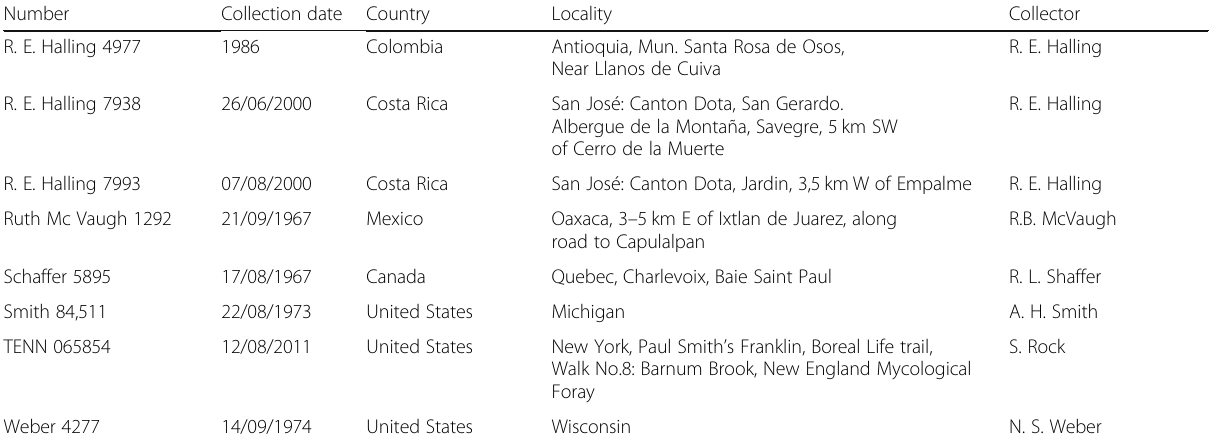
Table 2 Metadata of collections in the L. deceptivus complex